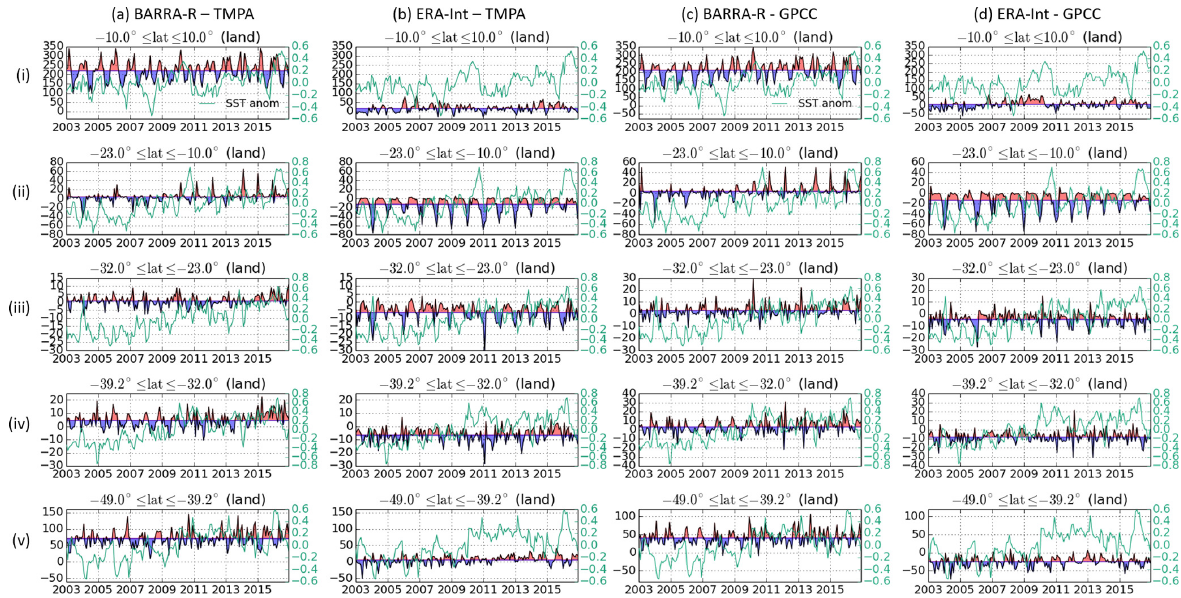
Figure 11. As with Fig. 10a and b, but over land. Additional comparisons are made between (c) BARRA-R and GPCC and between (d) ERA- Interim and